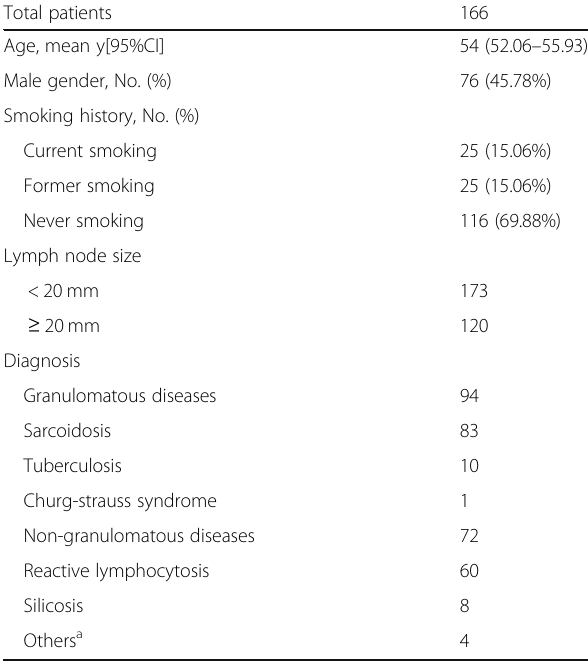
Table 1 Baseline Characteristics of Patients and Final Diagnosis Total